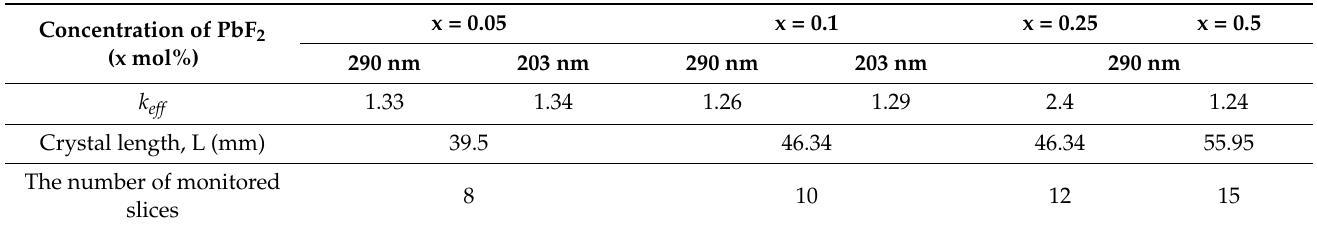
Table 4. Calculated effective segregation coefficient of BaF 2 : x mol% PbF 2 crystals.